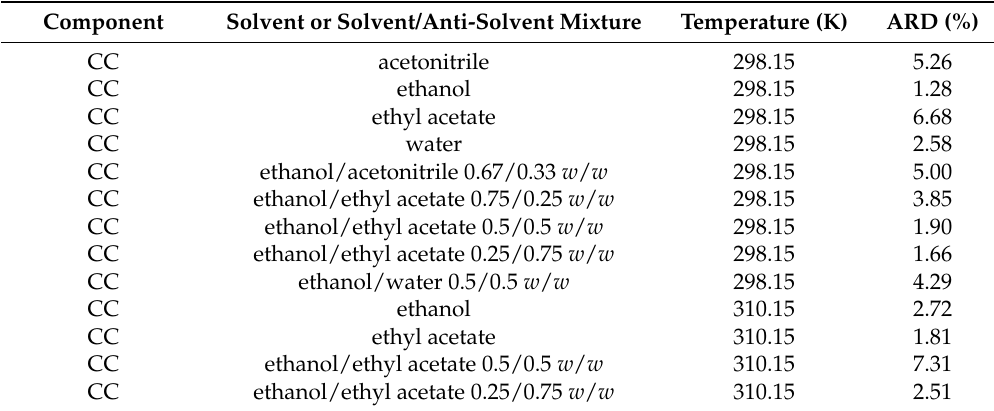
Table 8. Average relative deviation (ARD) of calculated and experimental solubilities of